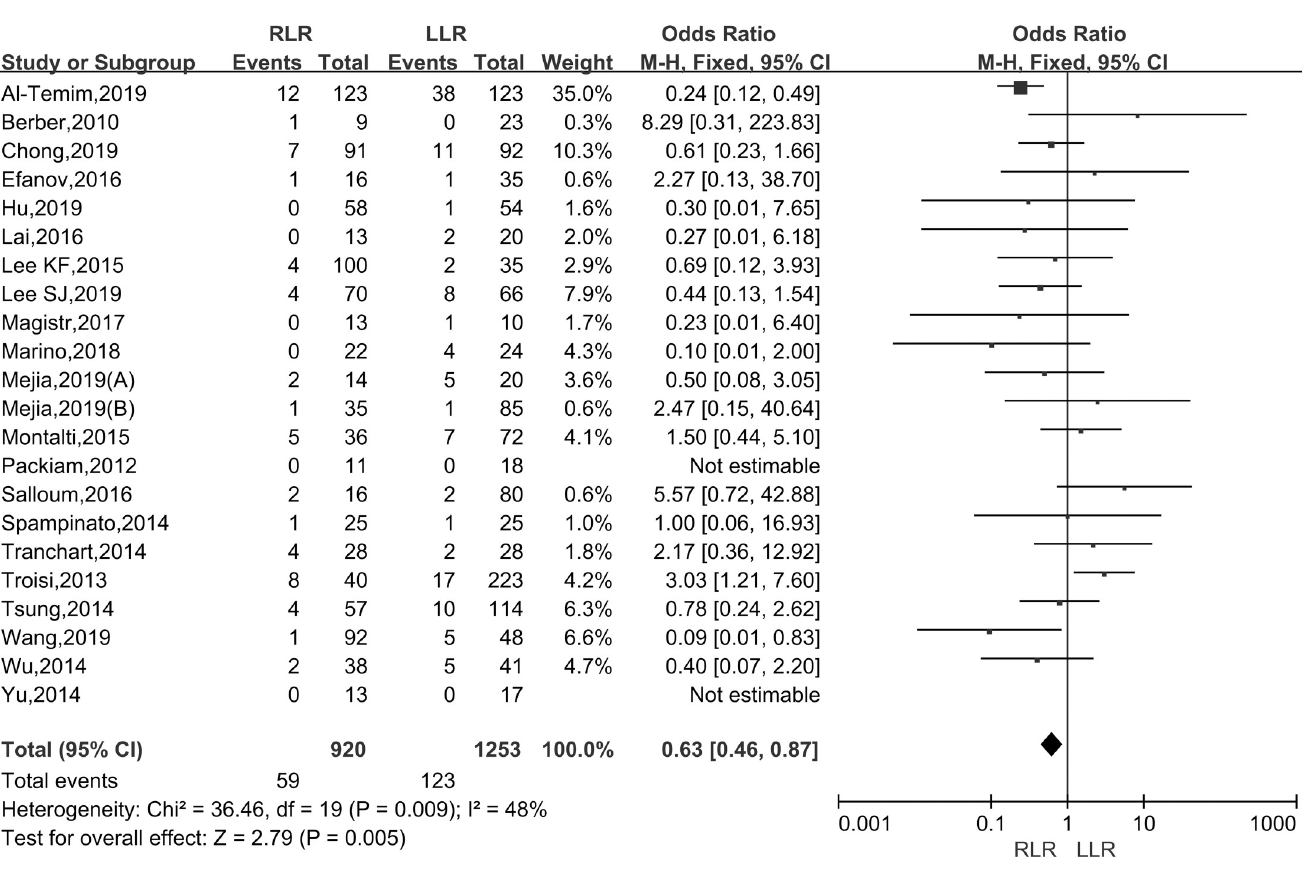
Fig 5. Forest plot of the meta-analysis on conversion